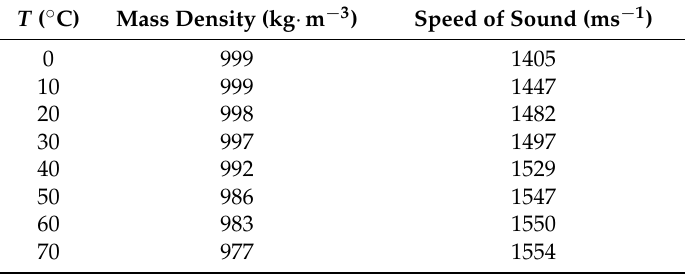
Table 2. Mass density and acoustic velocity of water at various temperatures.